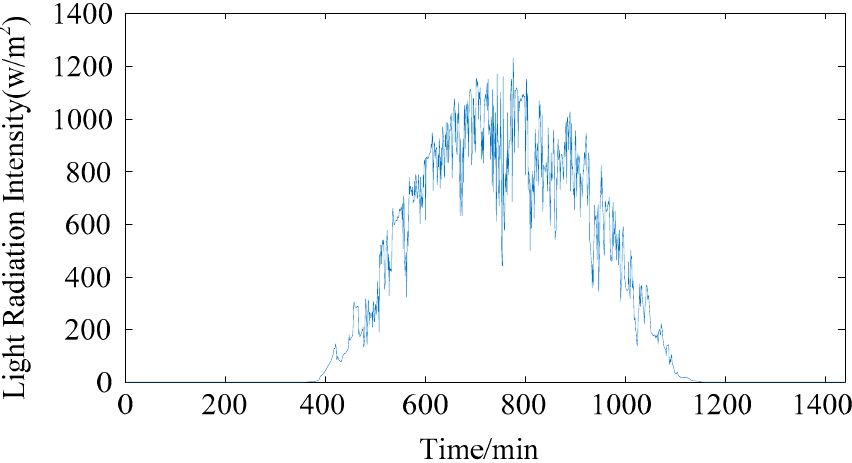
Figure 4. Typical solar radiation intensity.